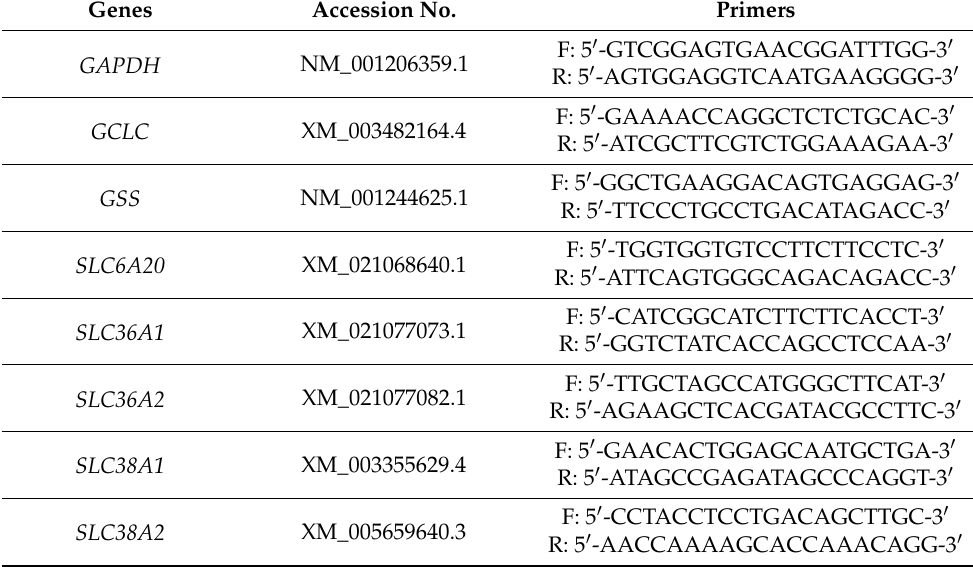
Table 1. Primers used for real-time